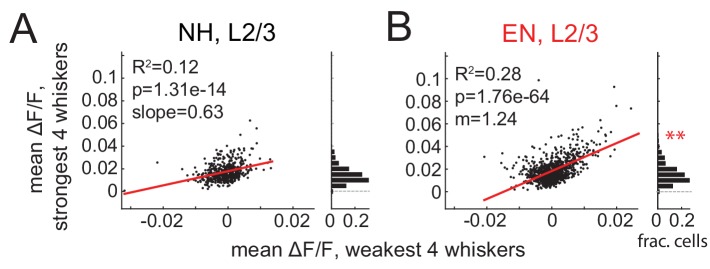
Response magnitude and tuning sharpness analyzed without normalization to spontaneous activity.Correlation of mean ΔF/F evoked by four weakest whiskers to four strongest whiskers within each L2/3 cell for NH (A) and EN (B). Each dot on scatter plots indicates one neuron. Red lines indicate linear regression fit. Histograms show distribution of absolute evoked response magnitude. ** denotes greater mean response for EN than NH (p=0.0002, permutation test). Note: in EN (B), one point at (0.03, 0.17) is omitted from scatter plot due to scale. Regression slope was different between NH and EN (p=1.2e-9, t-test for difference in slopes).